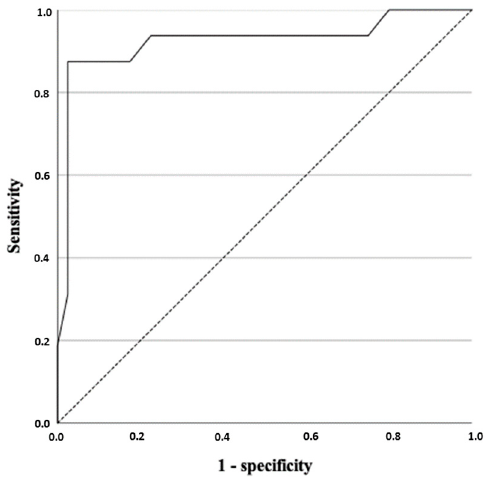
Figure 5. Receiver-operating characteristic curve for the peritumoral strain ratio (semiquantitative analysis) taking peritumoral fibrosis as the reference ( p ≤ 0.001).